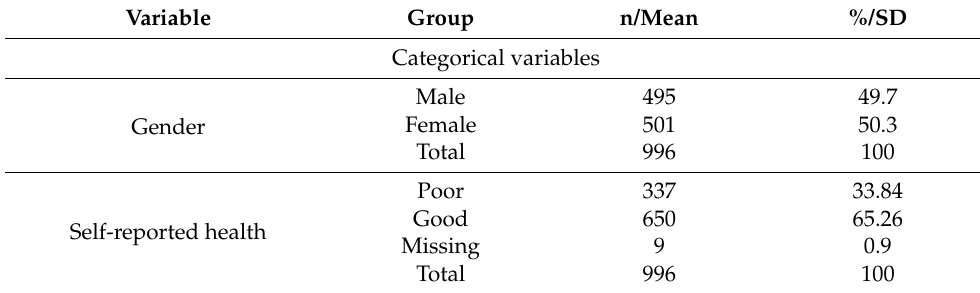
Table 1. A summary of the data with descriptive statistics (n = 996).